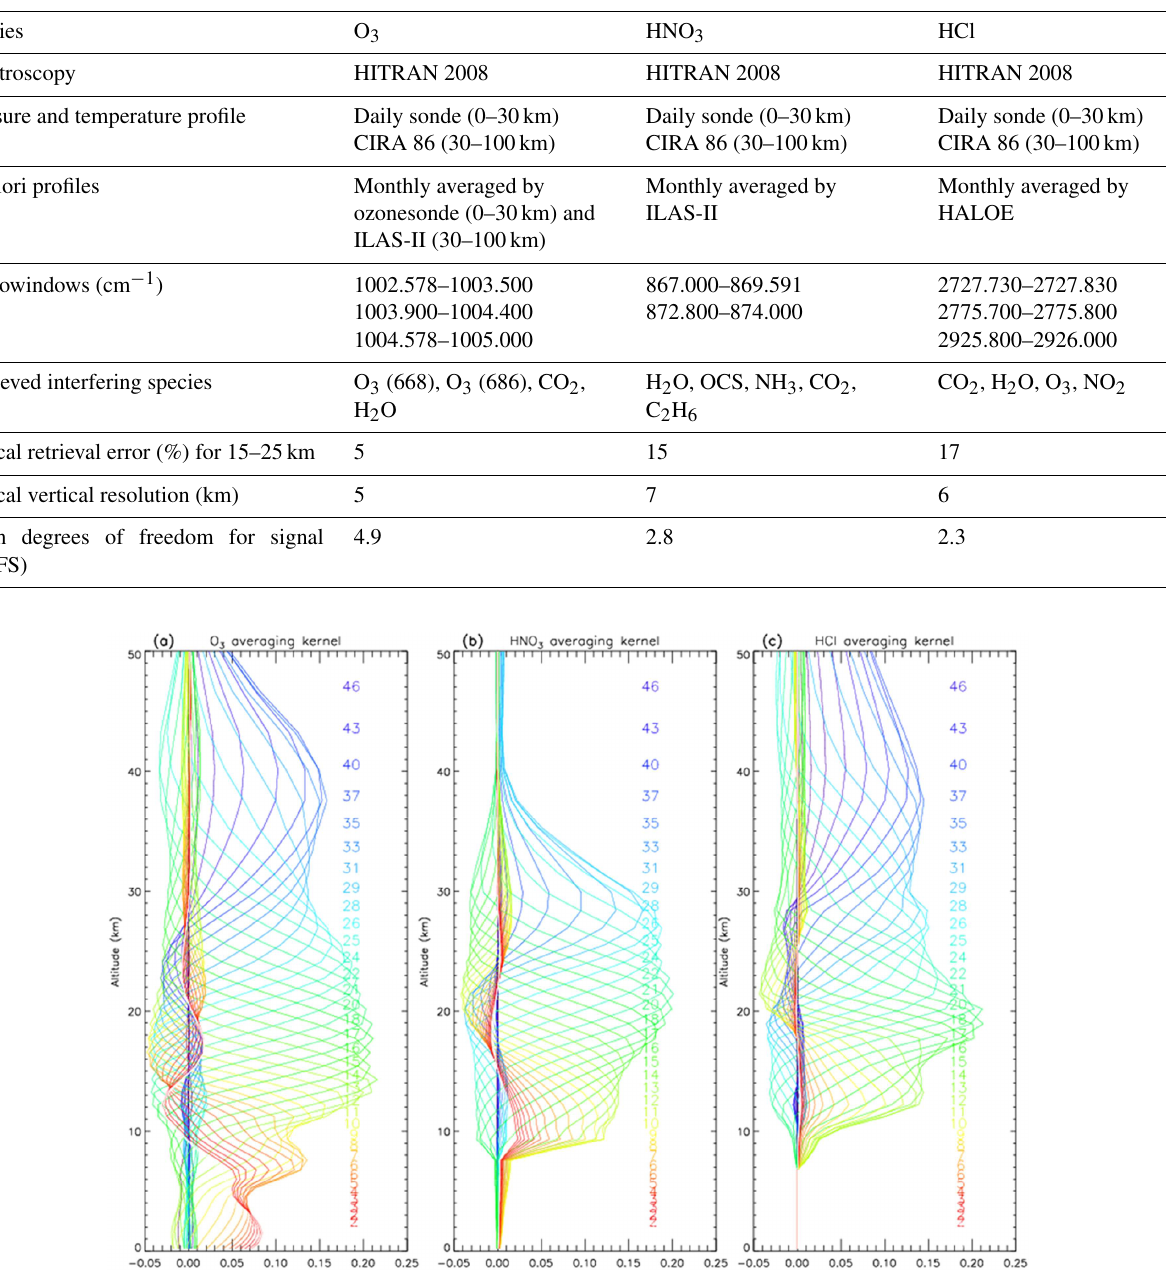
between 15 and 25 km was within − 10 . 4 % to + 24 . 4 %. The average of the mean relative differences D of O 3 for the alti- tude of interest in this study (18–22 km) was + 6 . 1 %, with the minimum of − 10 . 4 % and the maximum of + 19 . 2